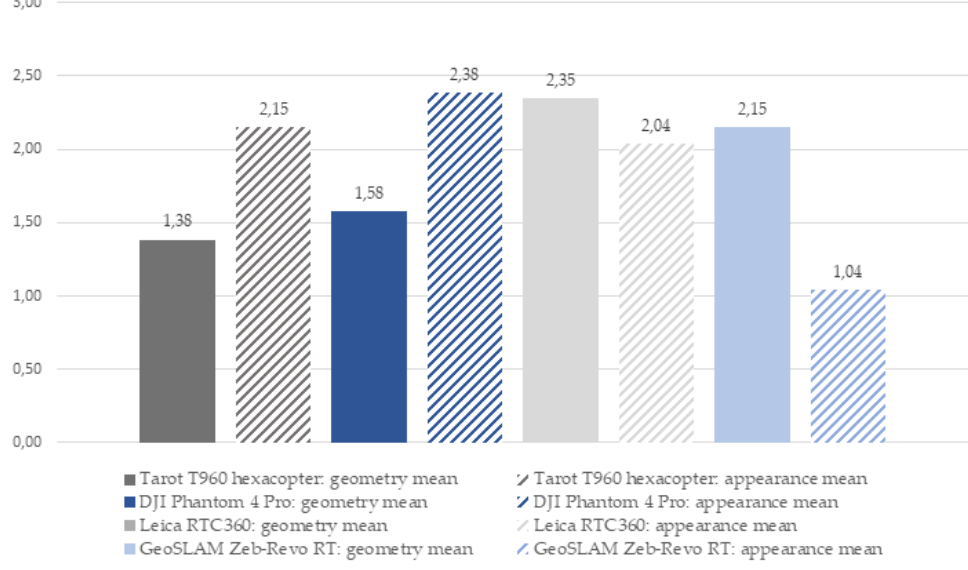
Figure 17. The mean results of all the point cloud data sets with geometry and appearance.